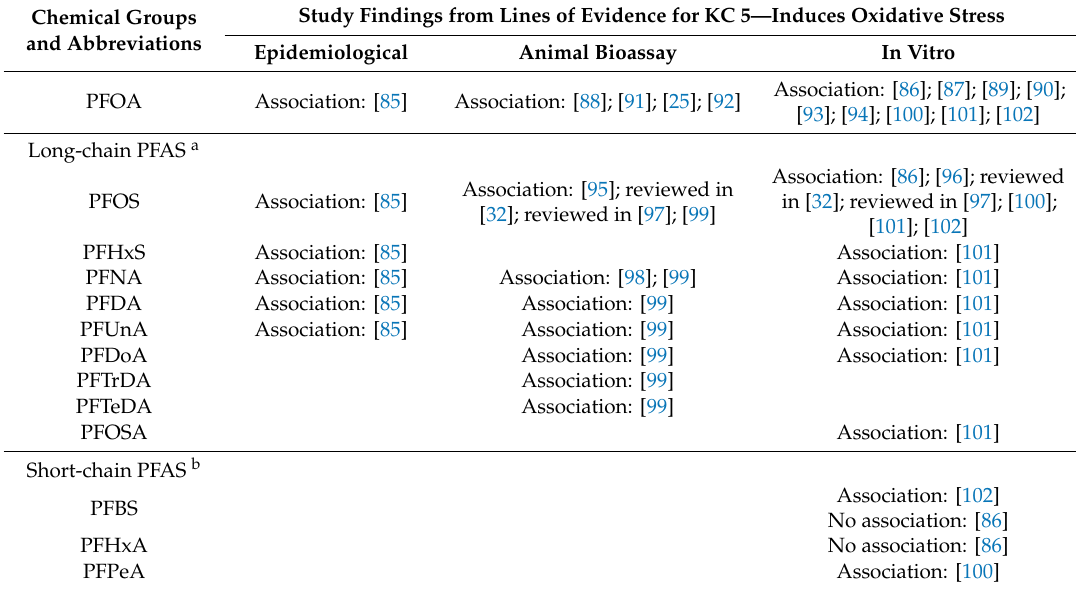
Table 4. Chemical specific study findings for key characteristic five—induces oxidative